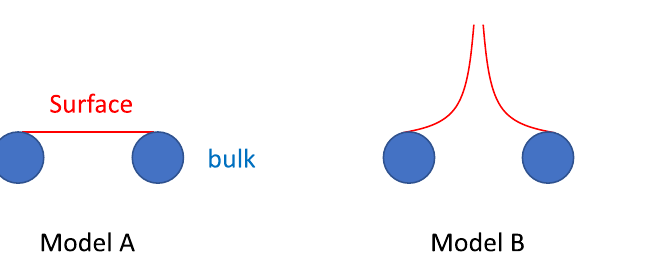
Figure 3. The energy contour of surface states for Model A (left panel) and Model B (right panel). The blue areas stand for bulk projections (enclosing WNs) and red lines are for surface states. That Fermi arcs in Model B do not connect is